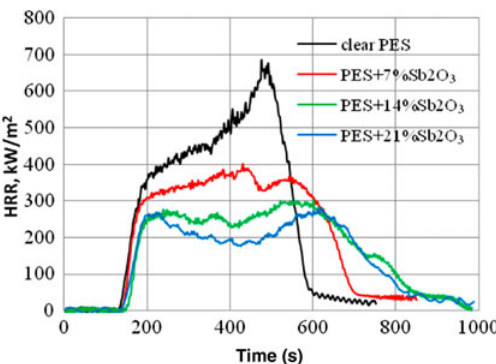
Fig. 5. Heat release rate for polyester material unmodified and modified with Sb 2 O 3 at the heat flux density of 50 kW/m 2 on piloted ignition